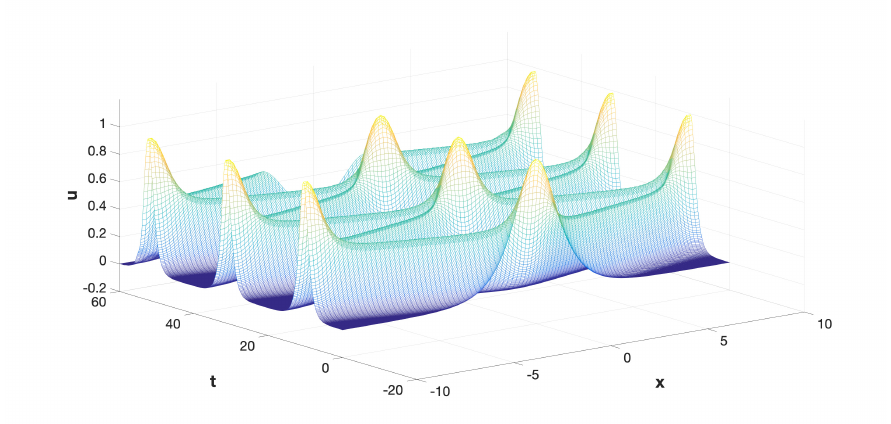
Figure 2. Calculated waveforms of the linear wave Equation